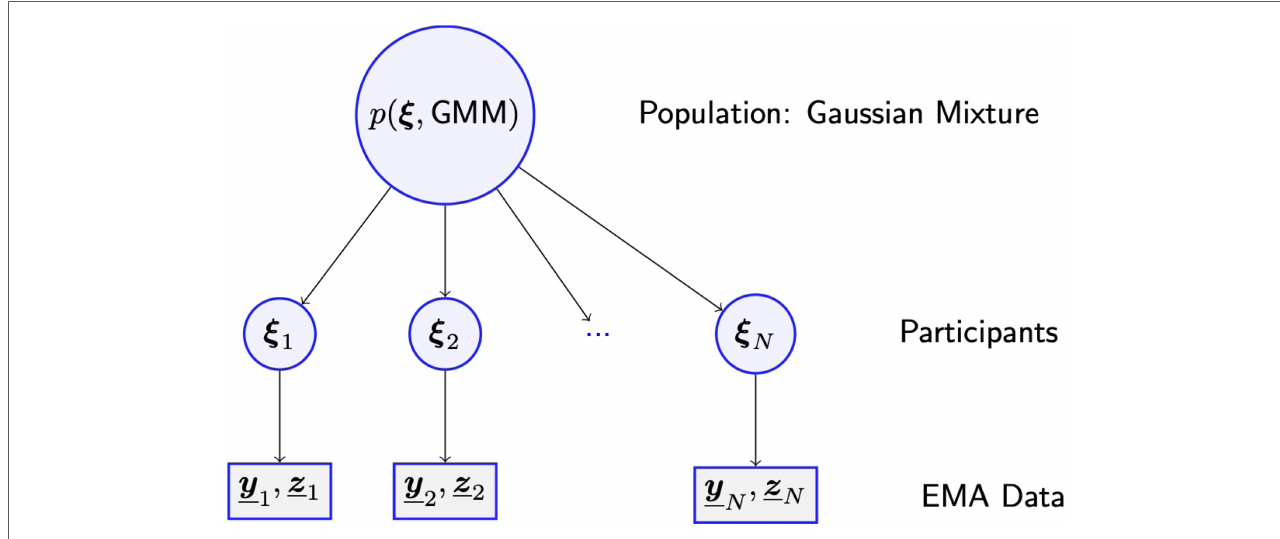
FIGURE 2 A hierarchical model is assumed to determine probabilities of all observed EMA data, including nominal responses z n about the listening situation and ordinal responses y n about perceptual attributes in the current situation, for the n th participant. The response probabilities are calculated as functions of a parameter vector j n which is regarded as a sample from the distribution of parameter vectors in the population from which the participants were recruited. Using all observed data, the Bayesian learning algorithm estimates probability distributions for parameters j n of each participant and the distributions of parameters j in the population, as well as for parameters specifying the population Gaussian Mixture Model